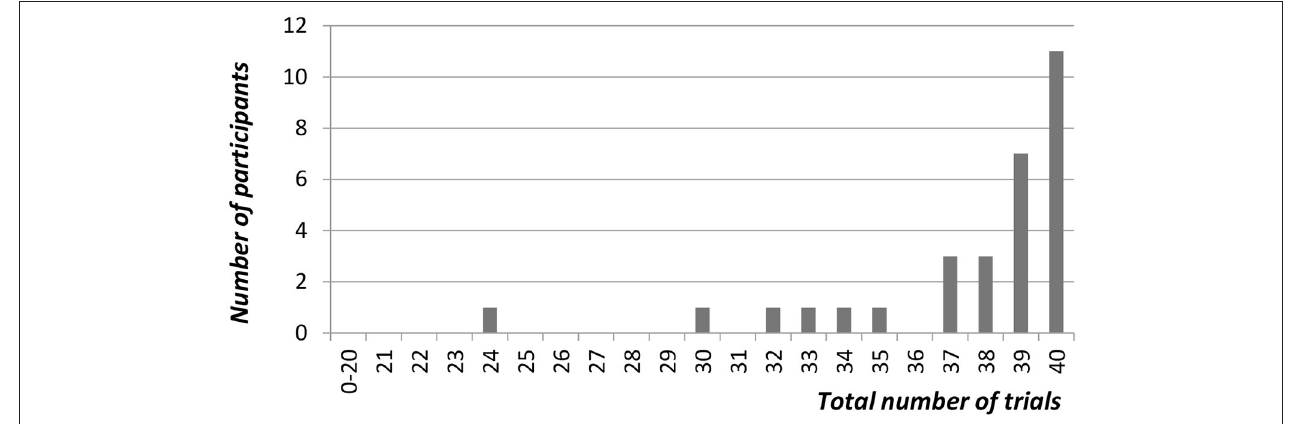
FIGURE 6 | The total number of trials for which participants used their hands to represent an object at least